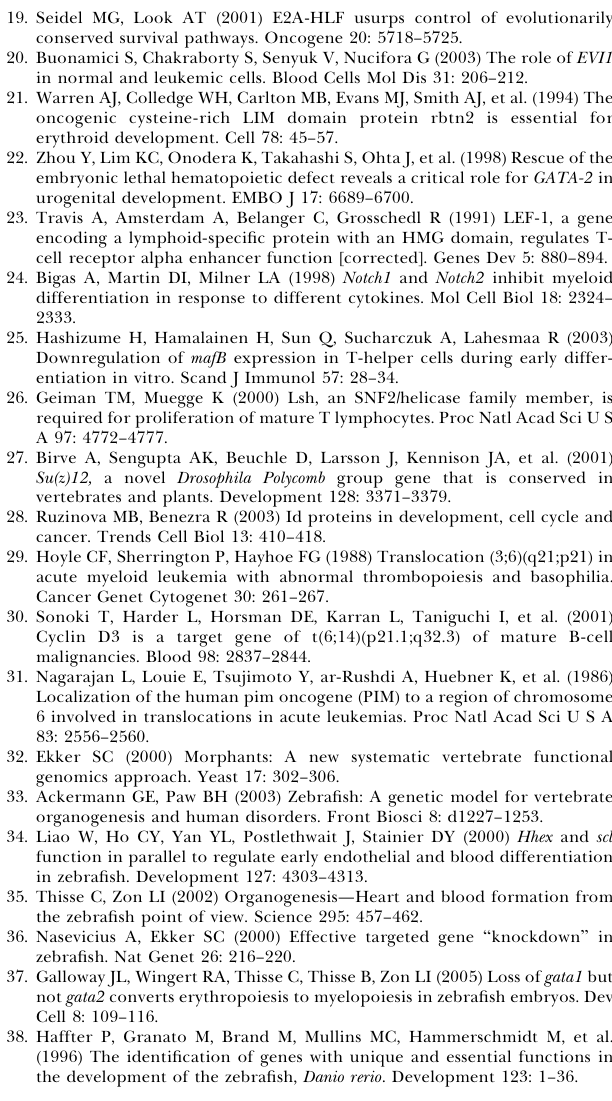
Table S7. Complete Phenotypic Descriptions for the 14 Zebrafish Morphants with Confirmed Blood Defects Found at DOI: 10.1371/journal.pbio.0030254.st007 (19 KB XLS). Table S8. Q-RT-PCR Primer